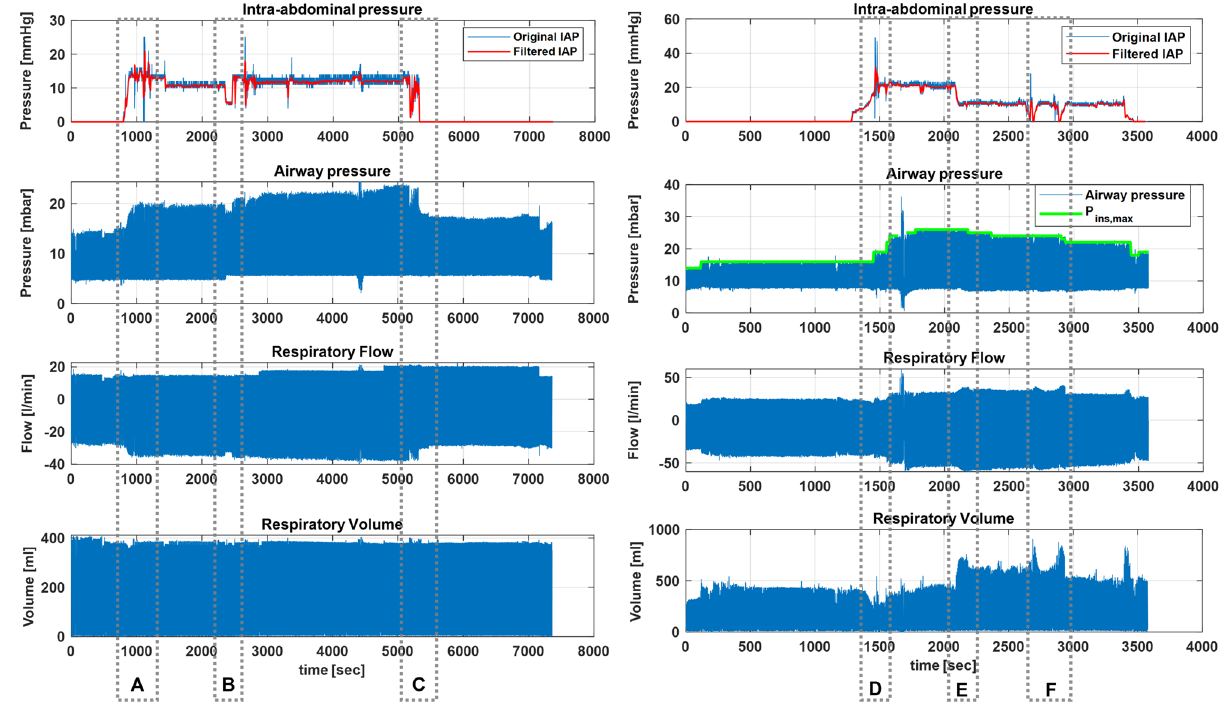
Figure 3. IAP, airway pressure, respiratory flow, and volume of VCV-patient (Subject 2, left) and PCV-patient (Subject 15, right). A, B, C show effects of changing IAP on respiratory parameters of VCV-patient, where PIP and negative peak flow increase or decrease when IAP increases or decreases, respectively. Similarly, D, E, F show effects of IAP in PCV-patient. Here, V T changes according to changes in